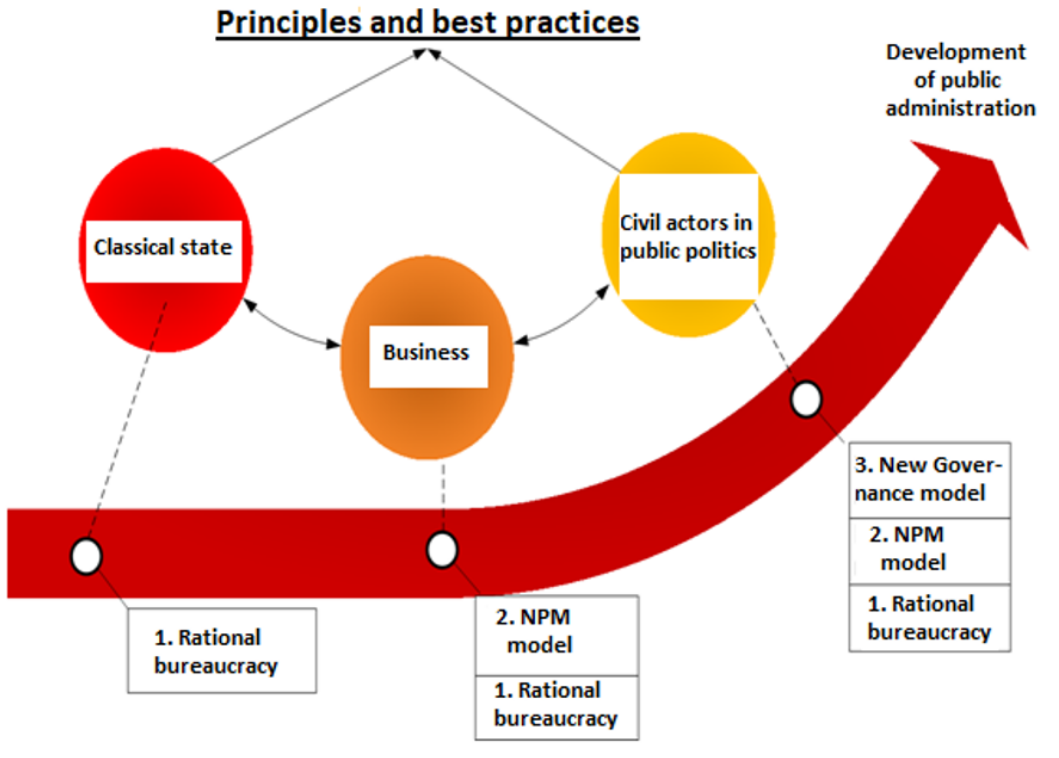
Fig. 1. The ratio of three ideal models of public administration from the practice of developed